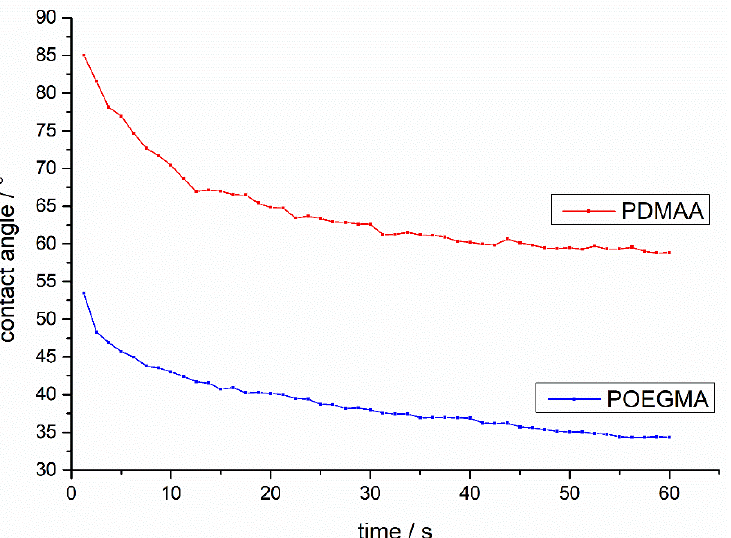
Figure 4. Dynamic contact angle measurements of P(OEGMA-co-MABP) and P(DMAA-co-MABP) on a PMMA slide. The coating was applied via dip-coating, crosslinked, and subsequently extracted for 20 min in water.